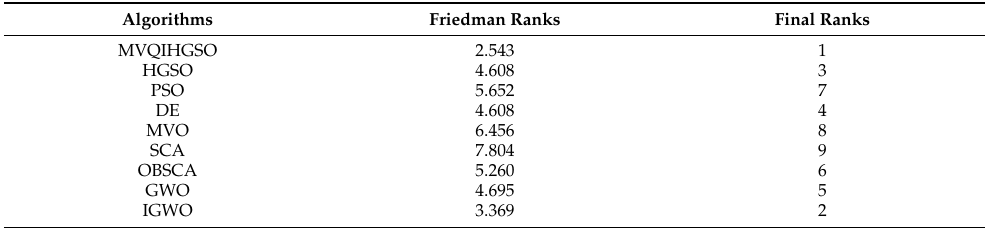
Table 5. Statistical results of the proposed MVQIHGSO and other state-of-art algorithms from Friedman test.